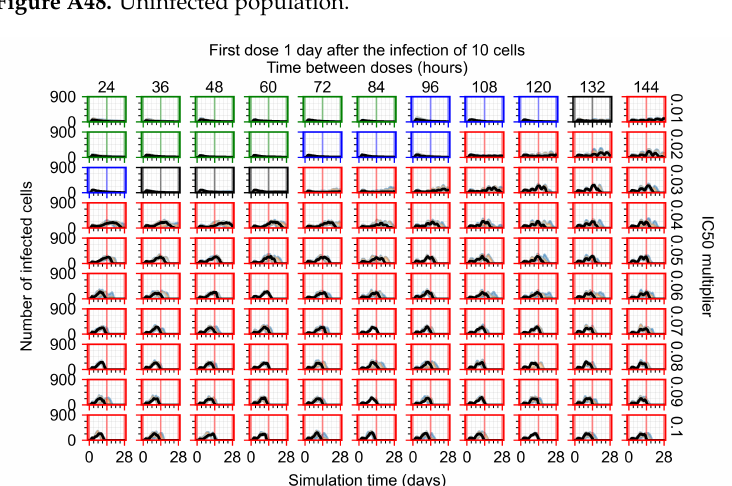
Figure A48. Uninfected population.